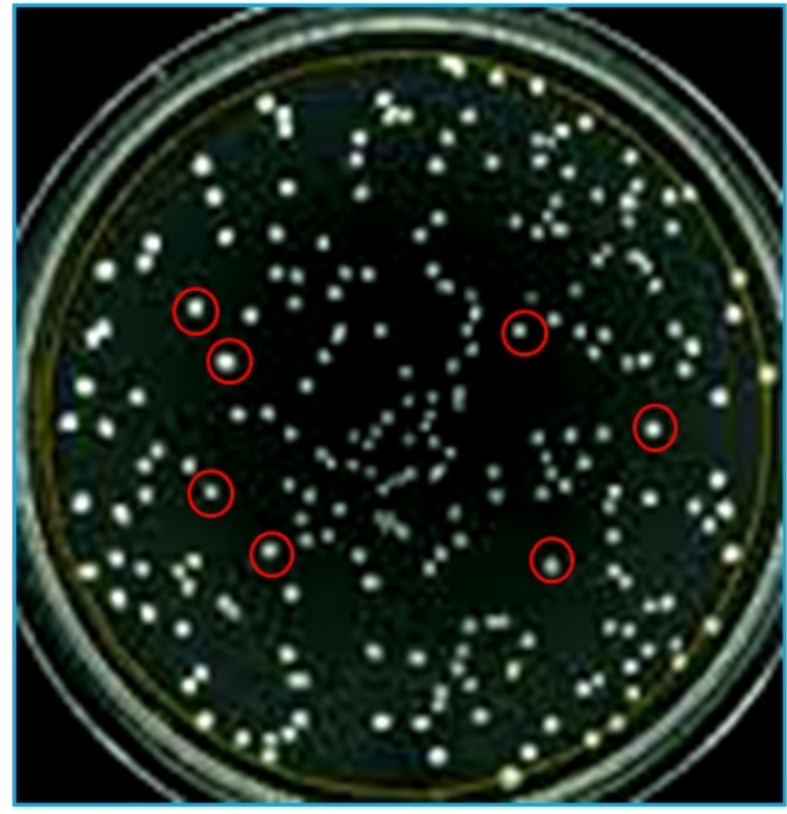
Figure 1. Colony morphology of Ah4 isolate on Ashby minimal agar plate.